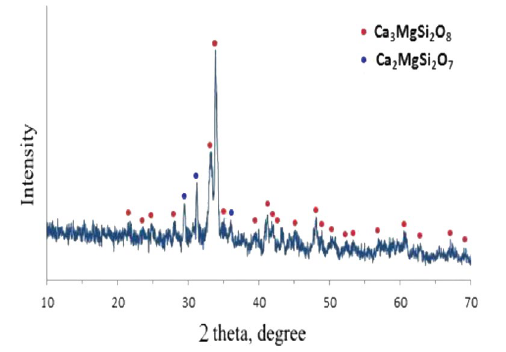
Fig. 1. XRD pattern of the powder sintered at 1350°C for 2 h.